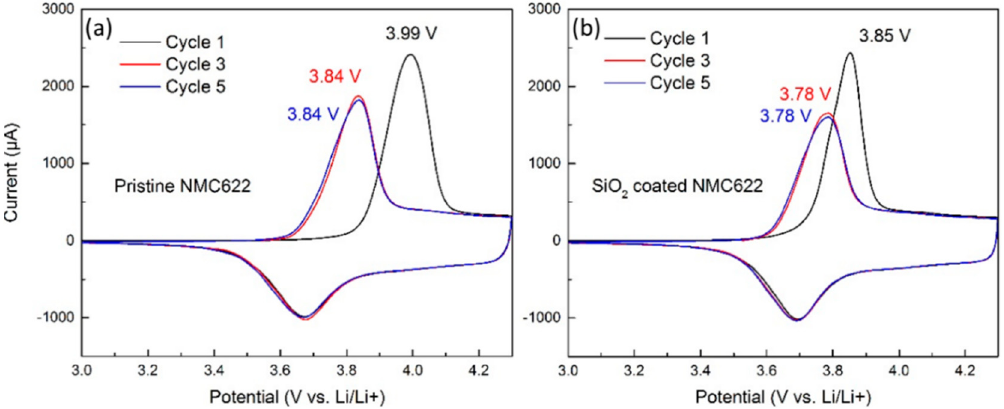
Figure 4. CV curves of ( a ) pristine and ( b ) SiO 2 -coated NMC622 electrodes.